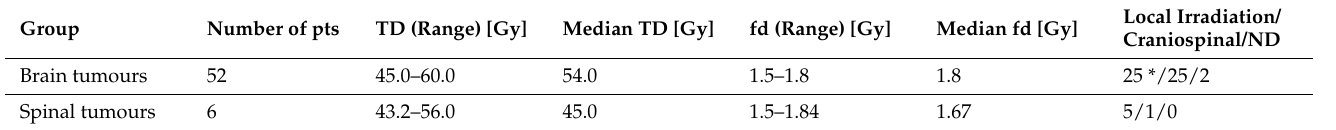
Table 2. The radiotherapy